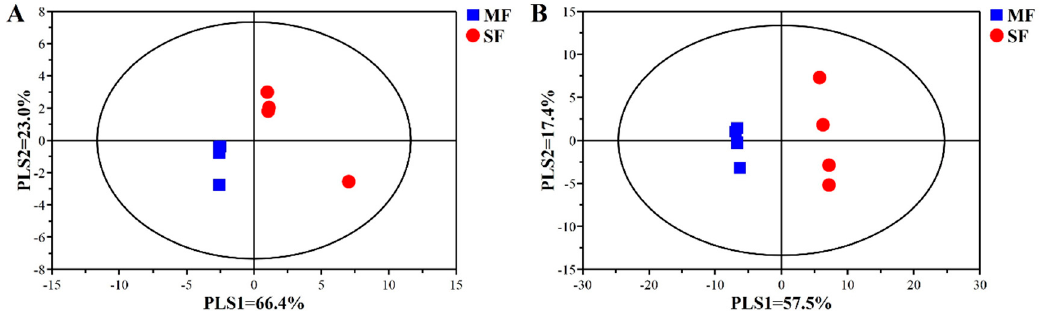
Figure 5. Partial least squares discriminant analysis (PLS-DA) of compounds from fermented feed samples in positive and negative mode. ( A ) PLS-DA score plot [predictive ability parameter (Q2) (cumulative) = 0.906, goodness-of-fit parameter (R2) (Y) = 0.951] in positive mode. ( B ) PLS-DA score plot [predictive ability parameter (Q2) (cumulative) = 0.994, goodness-of-fit parameter (R2) (Y) = 1] in negative mode. Table 3. Identification of significant key metabolites in fermented feed sample. (variable importance in the projection (VIP) > 1.2, false discovery rate (FDR) < 0.05, FC > 1.5 or FC < 0.67). Compounds RT a Mass VIP FDR FC b Maleic acid